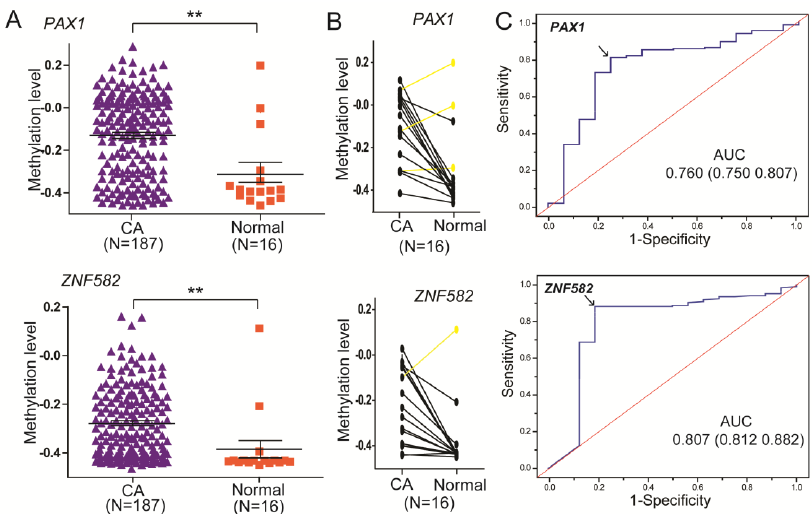
Figure 3. DNA methylation of PAX1 (cg08156066) and ZNF582 (cg11740878) analyzed in esophageal cancer samples using The Cancer Genome Atlas (TCGA) dataset. ( A ) The methylation level of PAX1 and ZNF582 in 187 esophageal cancer samples and 16 paracancerous samples. ** p < 0.05 was considered significant; ( B ) Methylation levels of PAX1 and ZNF582 in 16 esophageal cancer samples and their paired normal samples; ( C ) ROC curve analysis of PAX1 and ZNF582 for the diagnosis of esophageal cancers from paracancerous